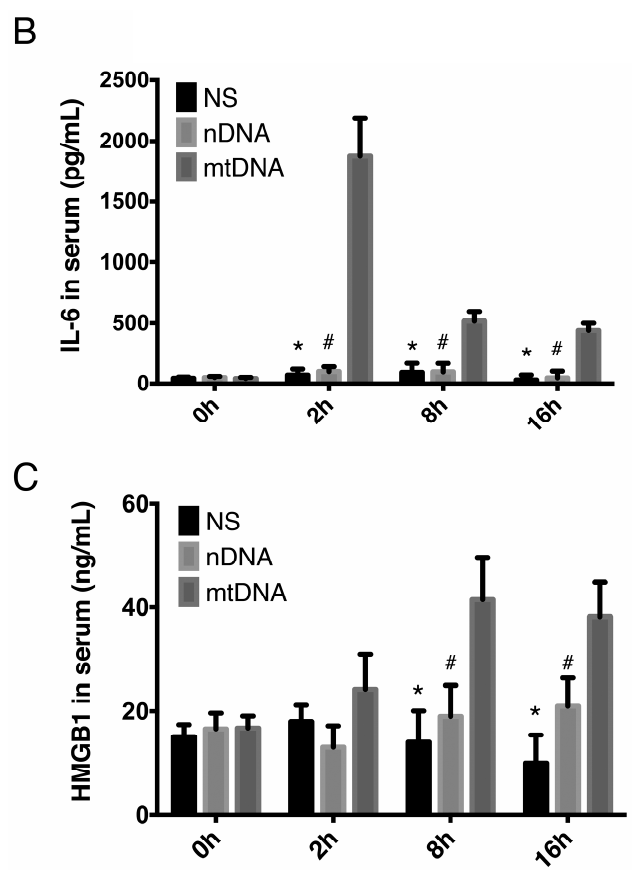
Figure 3. Intra-peritoneal administration of mtDNA leads to systemic inflammation. WT mice were treated with PBS, nuclear DNA (nDNA), or mtDNA via intra-peritoneal injection for 2, 8, and 24 h. Systemic inflammation and circulating levels of IL-1 β ( A ); IL-6 ( B ); and HMGB1 ( C ) were measured by ELISA. * p < 0.05 versus mtDNA group; # p < 0.05 versus mtDNA group. Eight mice were used in each set and data are mean ± SEM of three separate experiments.